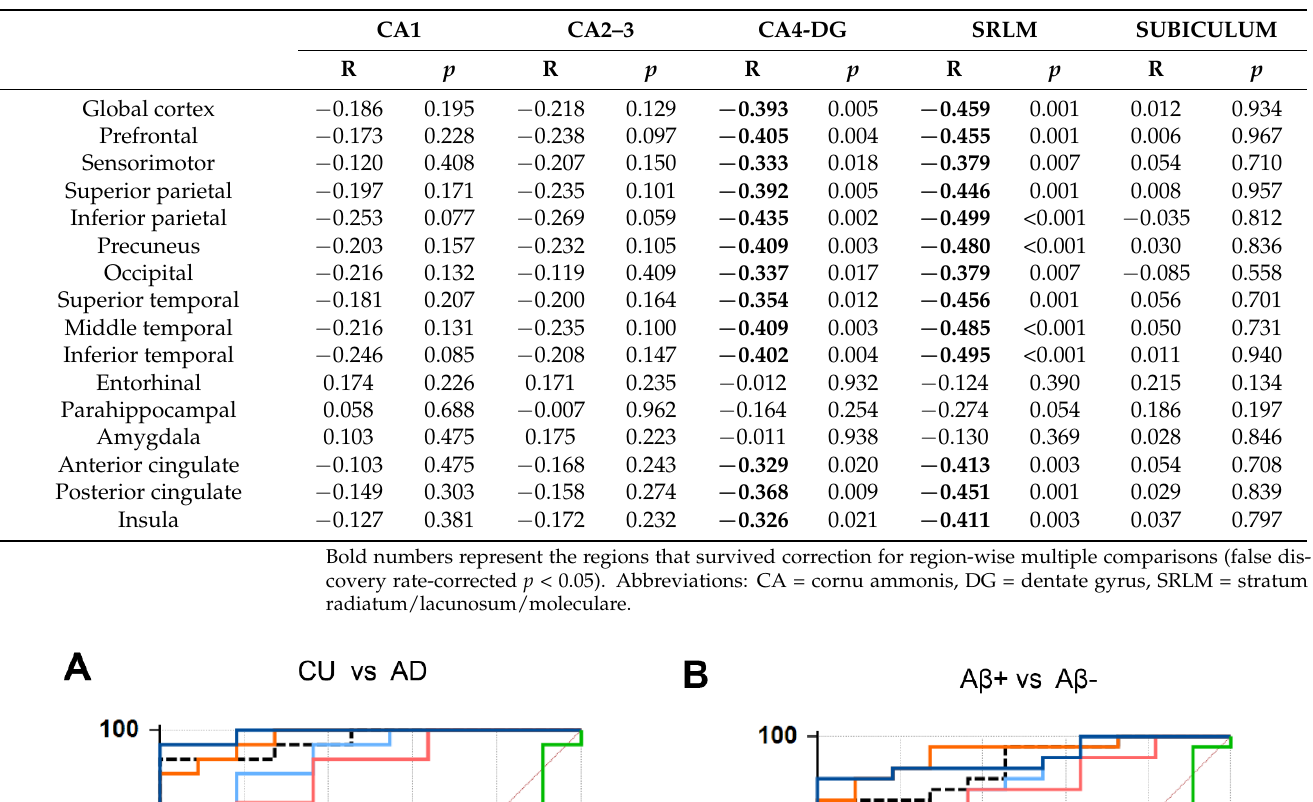
Table 2. Correlation of the hippocampal subfield volumes with the regional 18 F-florbetaben standard- ized uptake value ratio in all of the participants.